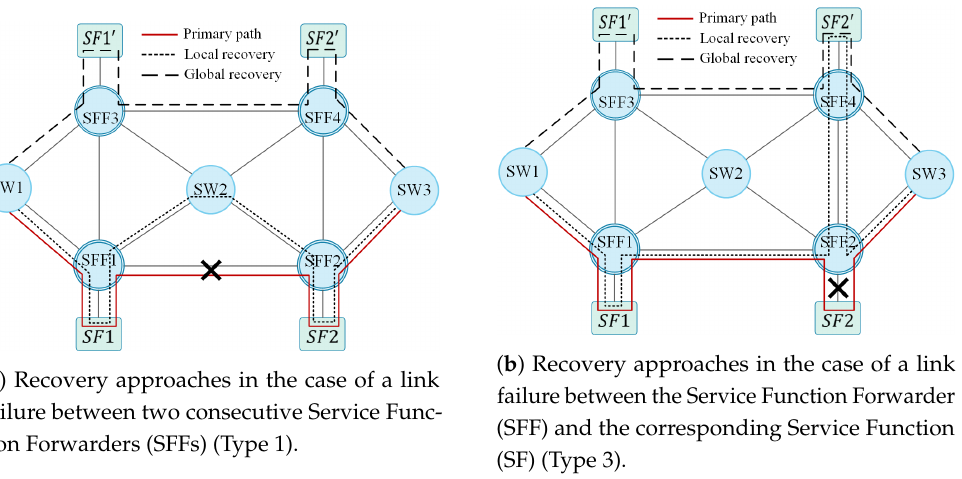
Figure 1. Local and global recovery for link failure ( a ) in the path between consecutive SFFs and ( b ) between the SFF and